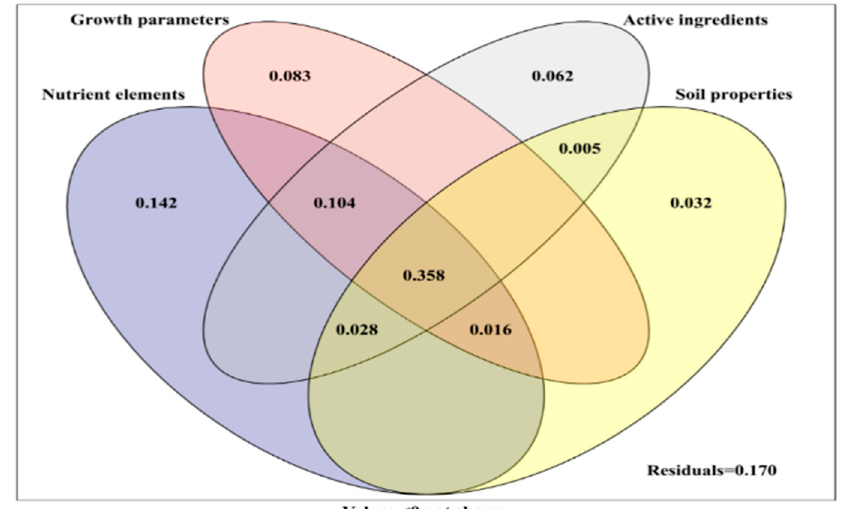
Figure 8. Variation partitioning of plant growth parameters, plant chemical composition (active ingredient, nutrient elements), and soil parameters on relative abundance of rhizosphere fungi.